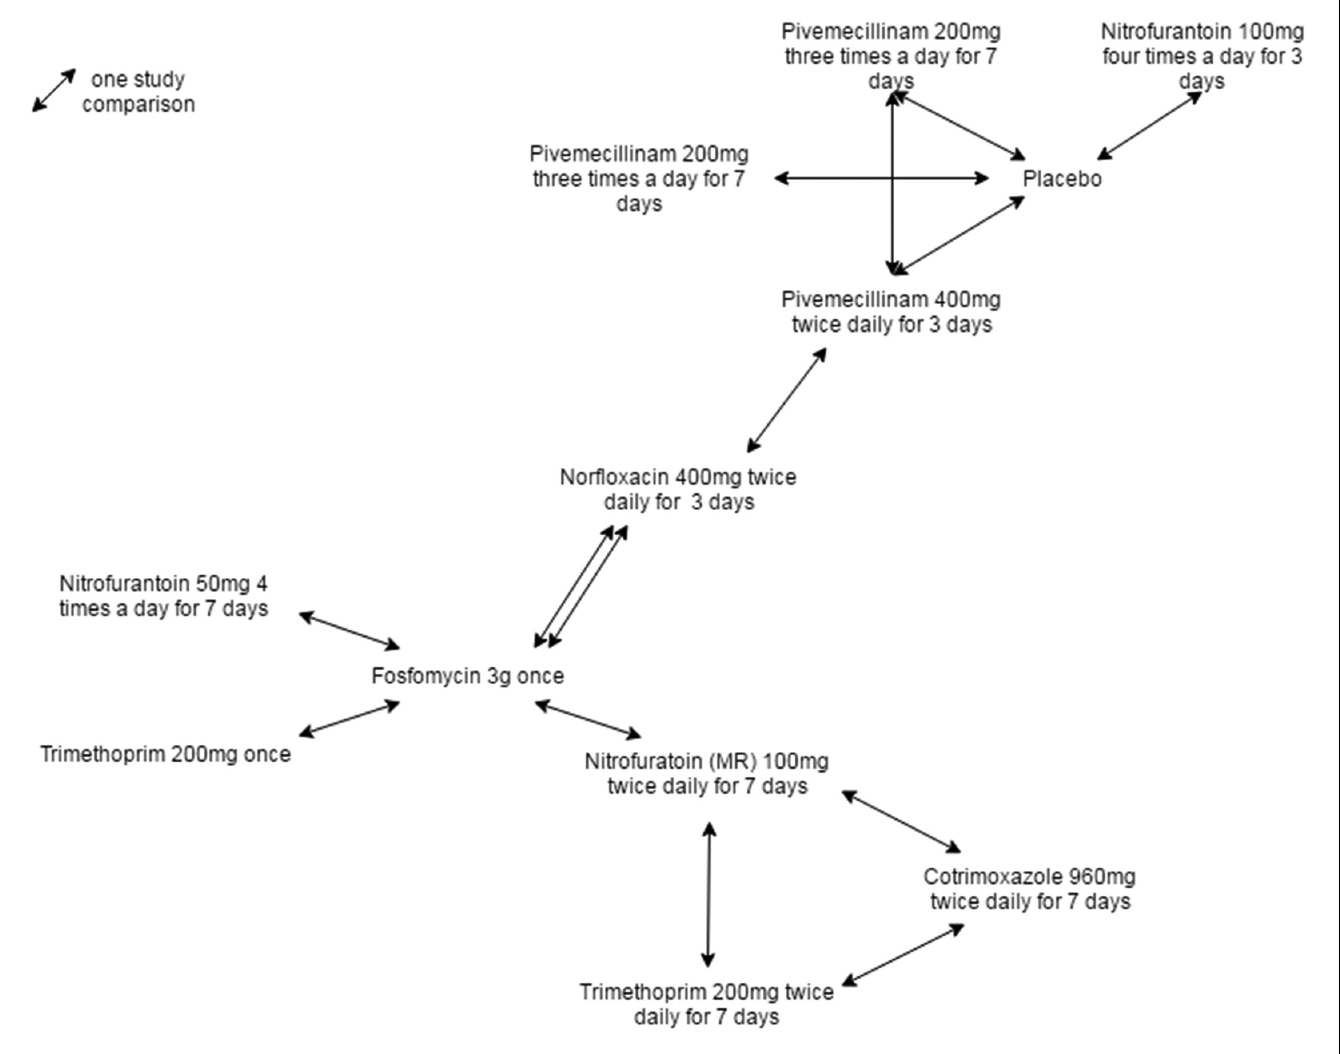
Figure 2. Network of trials identified in the systematic review and included in the network meta-analysis to estimate relative effectiveness of different treatment